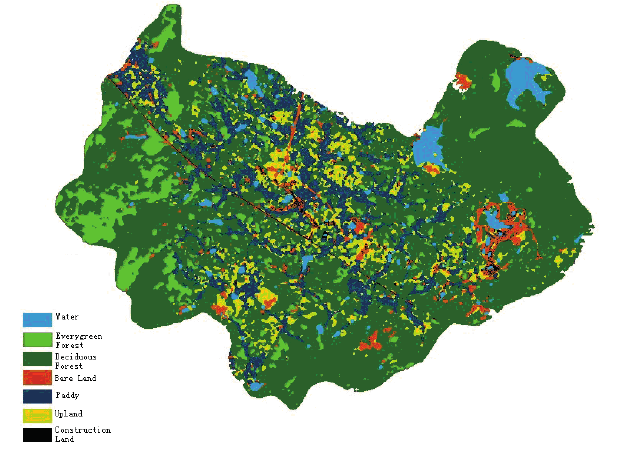
Fig. 4 Land-use map of the Huashan Hydrological Experimental Watershed.